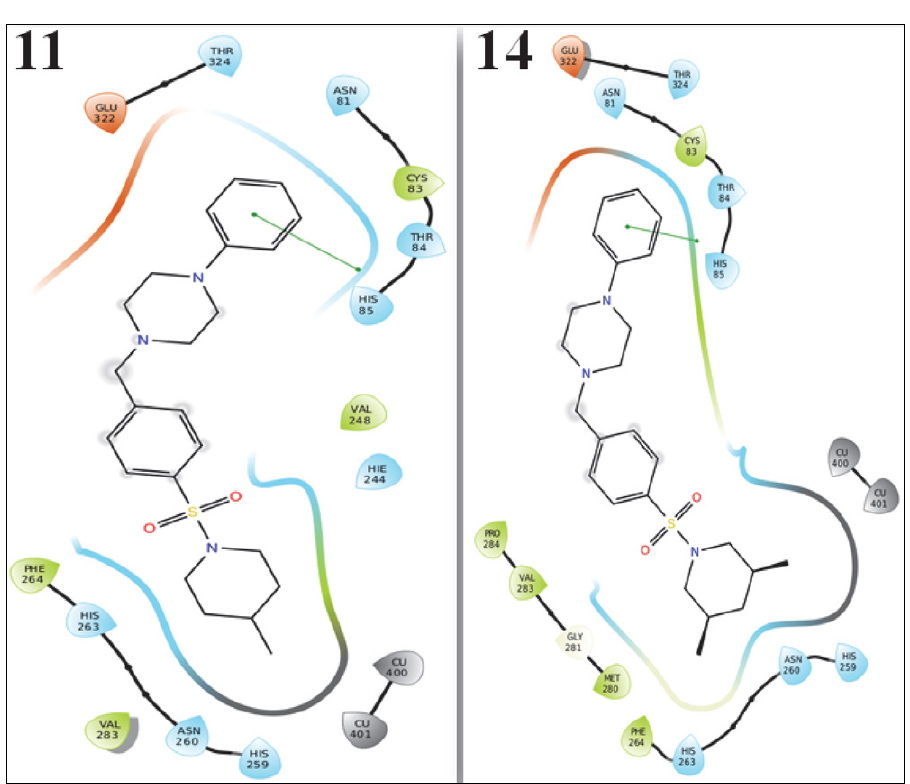
Figure 9. 2D binding interactions of 11 and 14 against tyrosinase